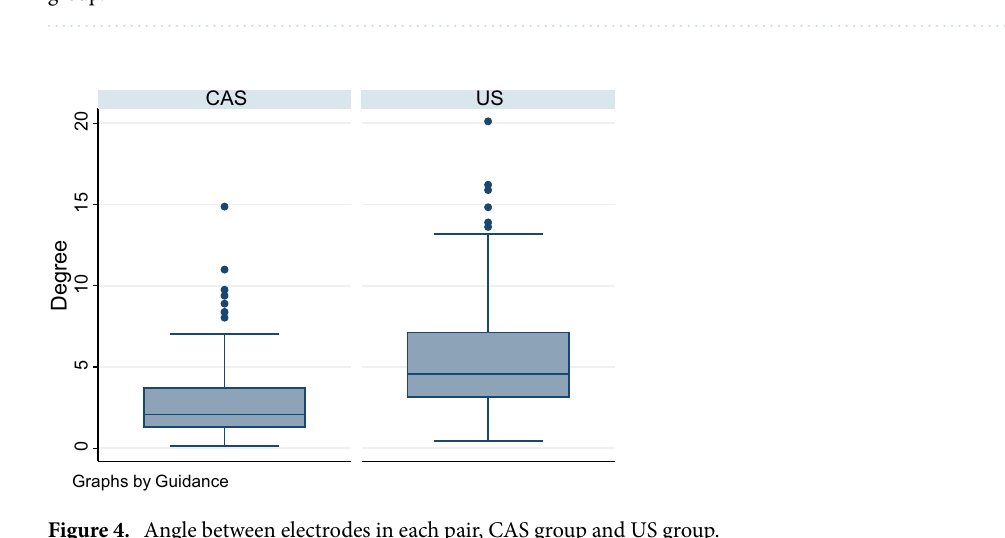
Figure 3. Deviation in millimetre from the optimal distance between the electrode pairs, CAS group and US group.